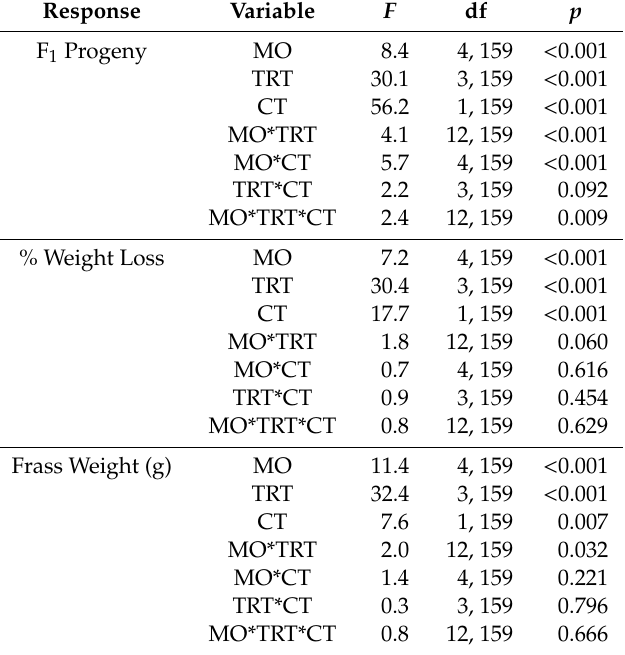
1 Means for exposure for progeny, weight loss, and frass weight, followed by the same lowercase letter, are not significantly di ff erent ( p ≥ 0.05, Proc t -test, SAS). Table 4. ANOVA Table for main e ff ects month (MO), Treatment (untreated controls, two rates of Diacon IGR + , and the Gravista formulation product), and count (CT, parental insects removed after 7 days or left continuously on the wheat for 8 weeks), and all associated interactions, for S. oryzae F 1 progeny, % of sample weight loss, and weight in grams of feeding